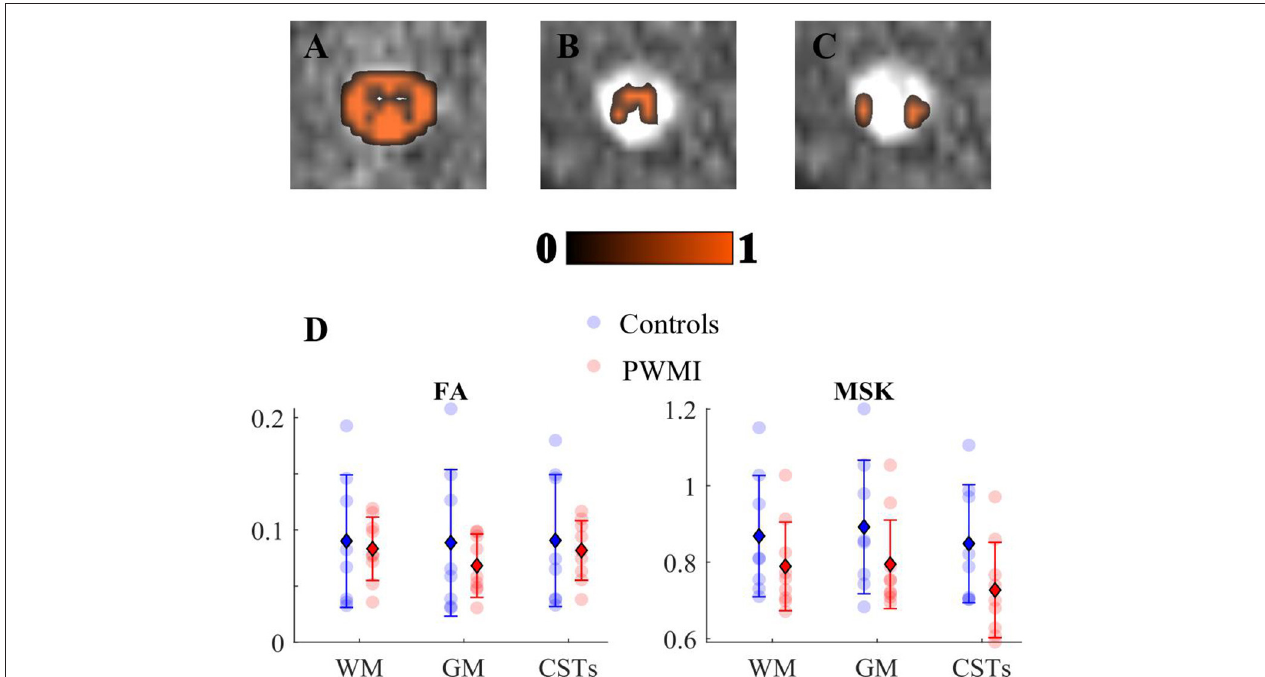
FIGURE 9 | Mean signal kurtosis (MSK) decreases in neonatal periventricular white matter injuries: (A) white matter, (B) gray matter, and (C) cortico-spinal tract regions of interest (ROIs) overlaid on diffusion kurtosis imaging motion-corrected image. (D) Scatter plots of fractional anisotropy (FA) and MSK in group subjects across the aforementioned ROIs: colored spots indicate single subject’s value for each metric; as reported in the legend, controls’ measures are in blue, whereas the periventricular white matter injury group is in red. The units for MSK are in mm 2 /s, while FA is dimensionless. Error bars displaying mean (diamond) and standard deviation (bars) are overlaid on scatter